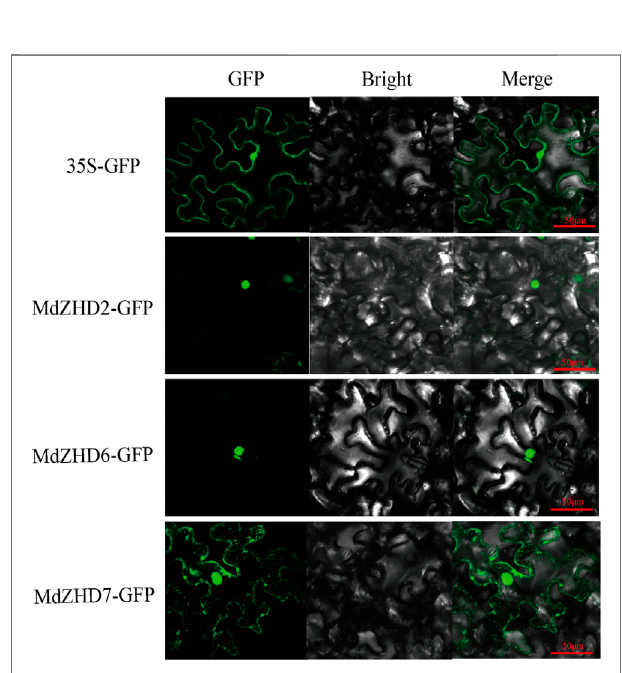
FIGURE 8 | Subcellular localization of MdZHD2/6/7 -GFP in tobacco leaves. Agrobacterium-mediated transformation was expressed in